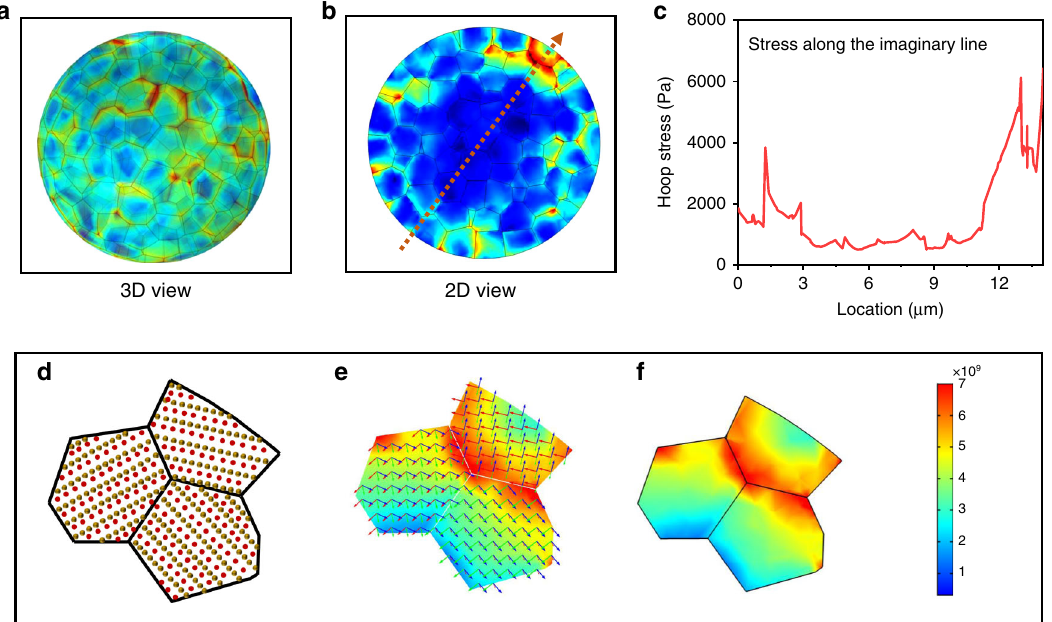
Fig. 6 Finite element modeling of the cathode polycrystalline particles. The equivalent stress within the NCM particles upon completion of charging (Li extraction) of ASSLBs. ( a ) three-dimension view with 50% transparency ( b ) two-dimensions view of cross-section, and ( c ) stress distribution within the NCM particles along the imaginary line in Fig. 6b. Diagram of heterogeneous mechanical stress distribution in the select district. ( d ) different crystalline orientation, ( e ) different lithium diffusion orientation, and ( f ) stress distribution in the primary